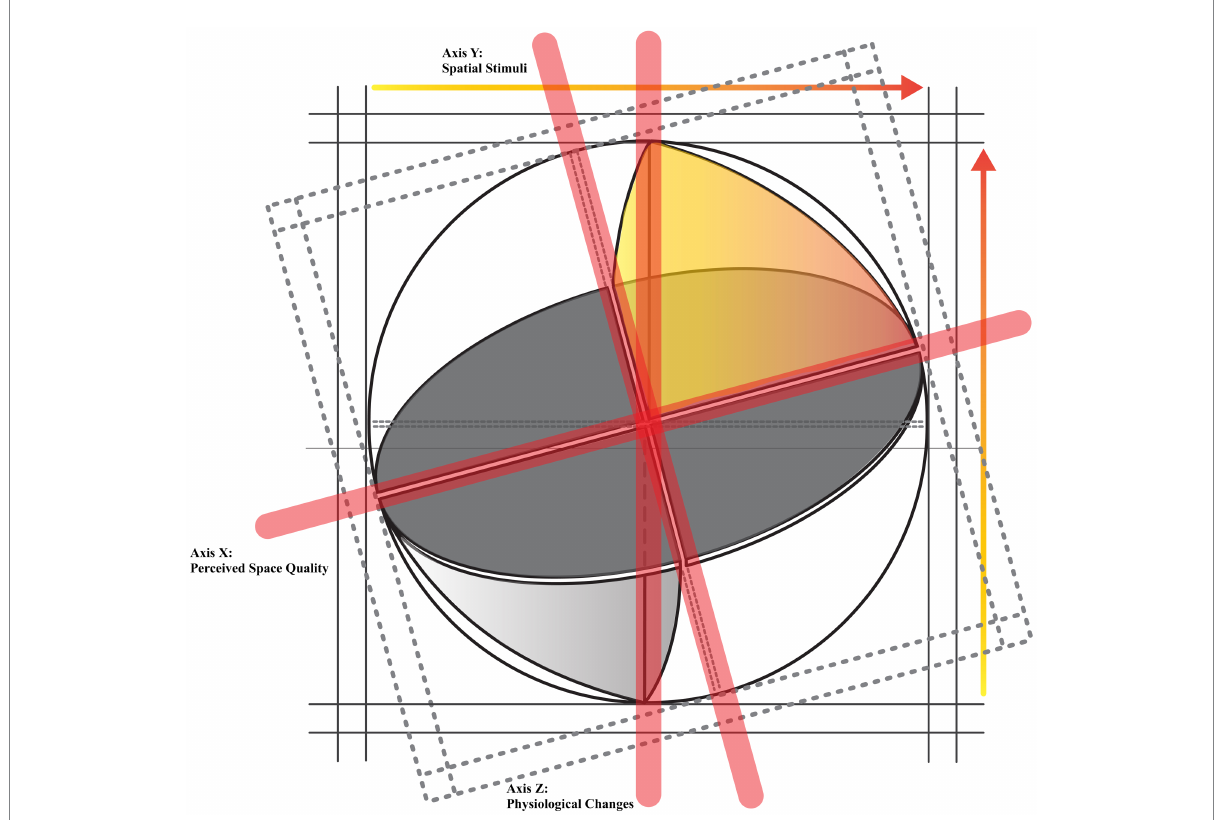
FIGURE 1 The present research’s theoretical model inspired by Mehrabian and Russell’s tripartite model of pleasure, arousal, and dominance (Bakker et al., 2014). The yellow–orange sector of the sphere illustrates the association between increased axes of Perceived Space Qualities, Spatial Stimuli, and Physiological